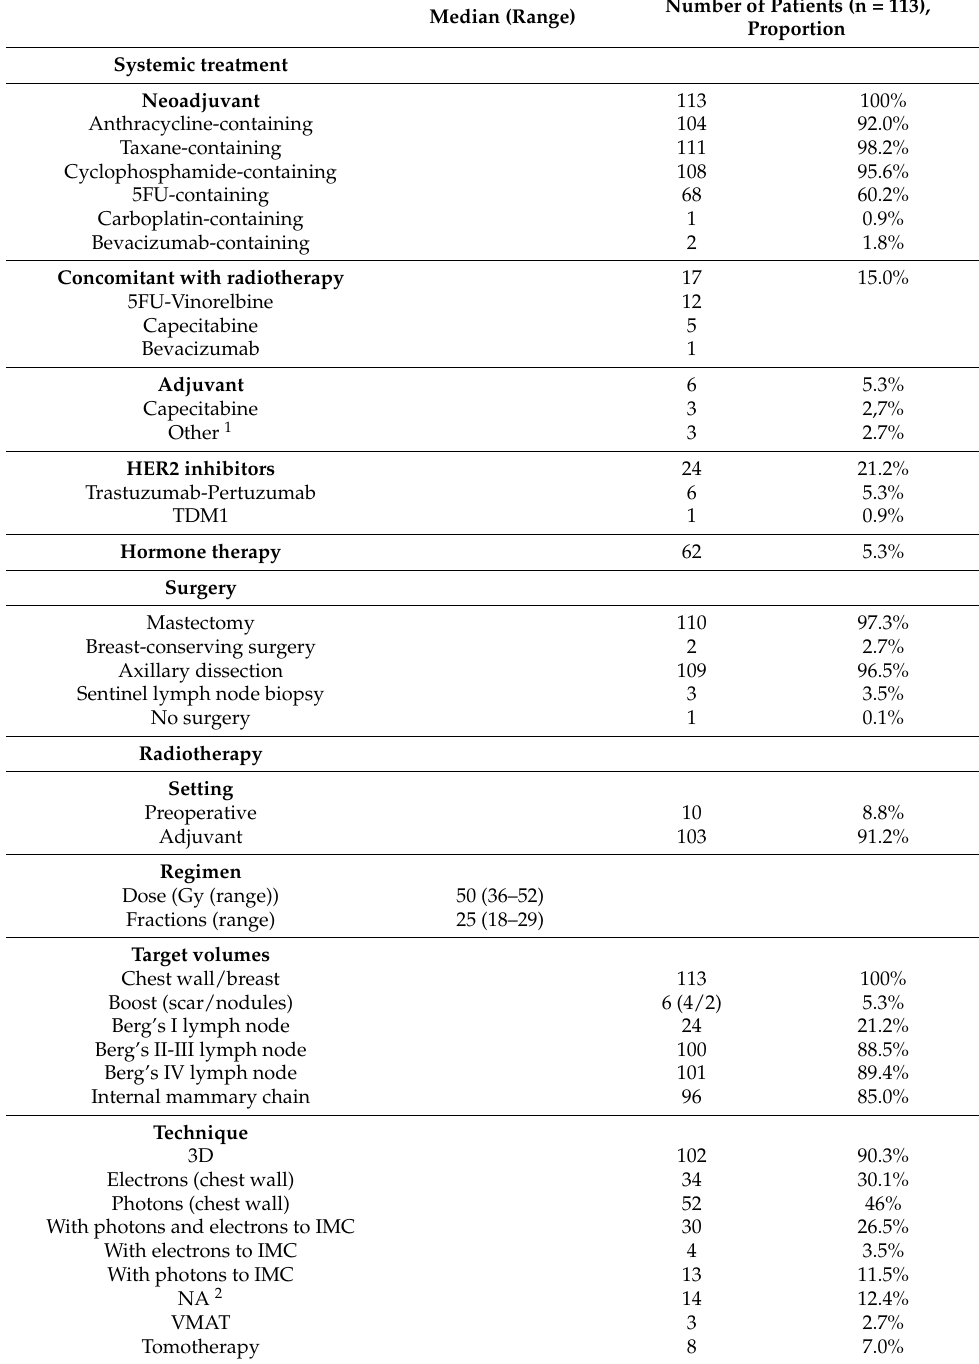
Table 2. Treatment